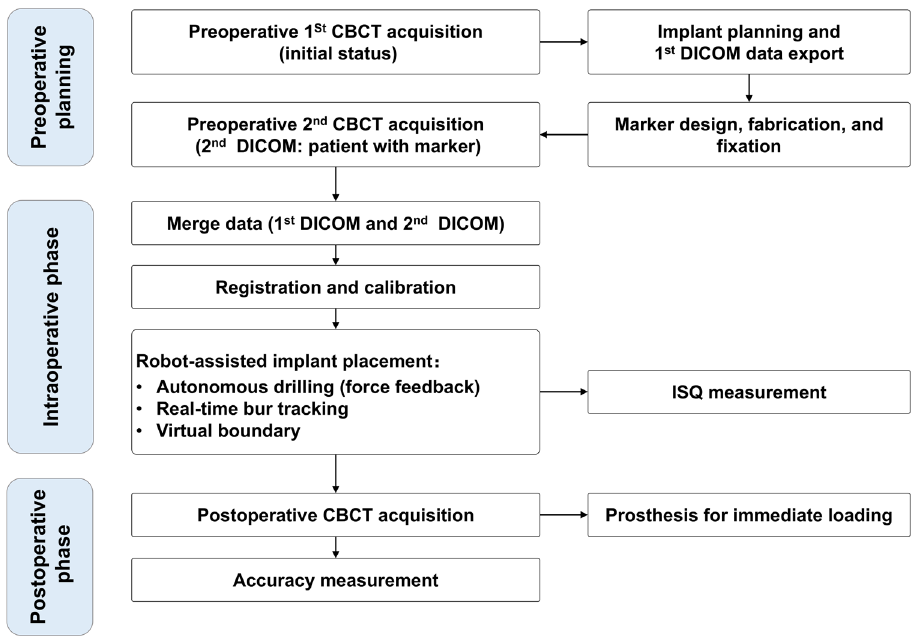
Figure 3. The treatment protocol of robot-assisted implant surgical system for full-arch fixed implant rehabilitation. CBCT, cone-beam computed tomography; DICOM, digital imaging and communications in medicine; ISQ, implant stability quotient.